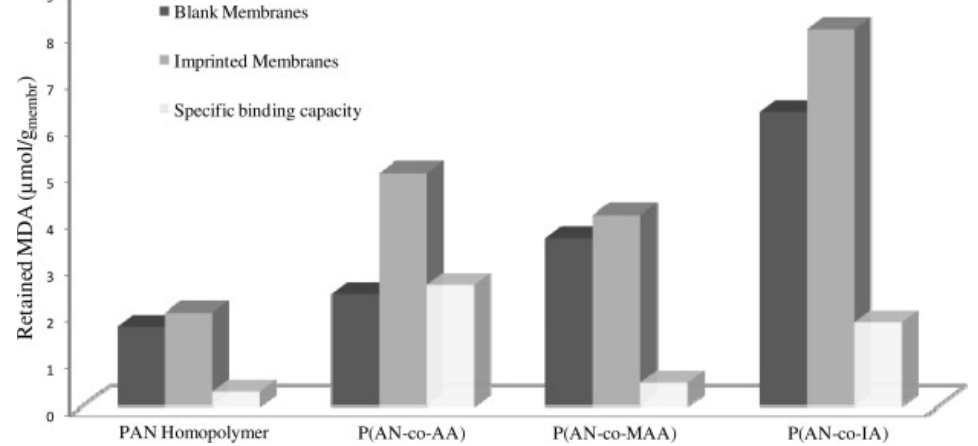
Figure 9. 4,4'-methylenedianiline, (MDA) retention and specific binding capacities of the membranes prepared using PAN and the different acrylic